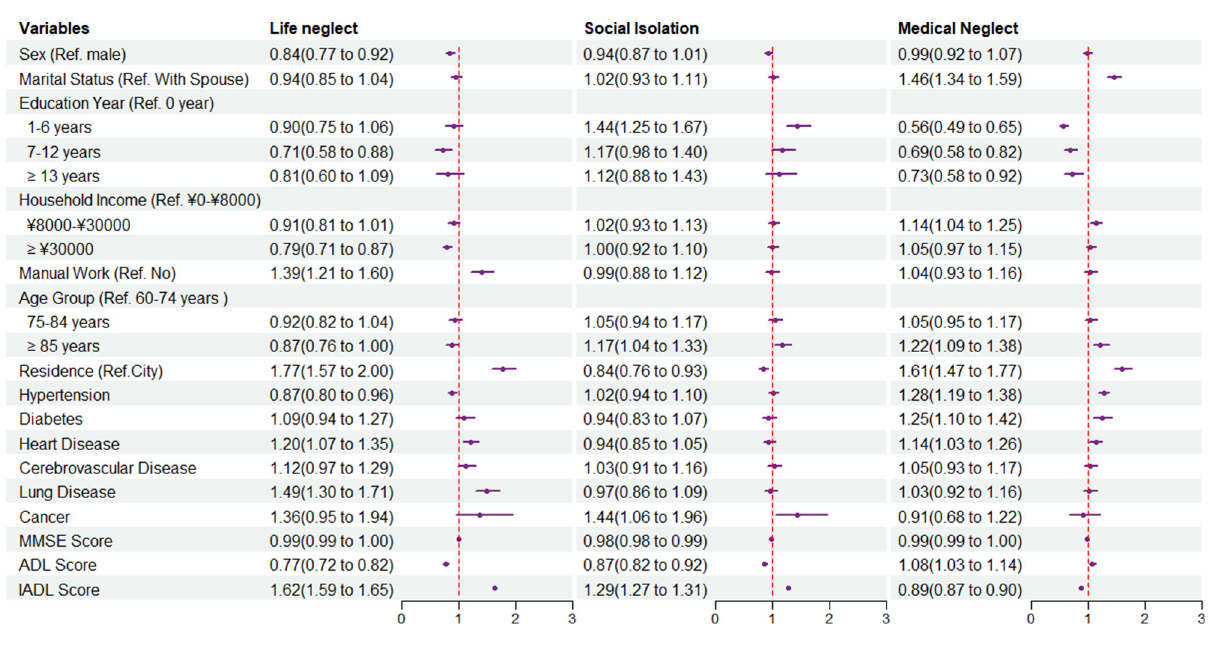
FIGURE2 Forest plot of odds ratios (ORs) and 95% confidence intervals of each characteristic in life neglect, social isolation, and medical neglect by multivariate logistic regression.